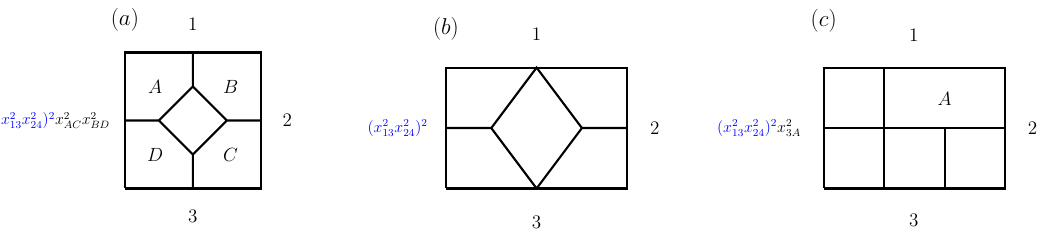
Figure 14 . Five-loop conformal integrals contributing to the next-to-fishnet scattering amplitude M (5) 2 , 2